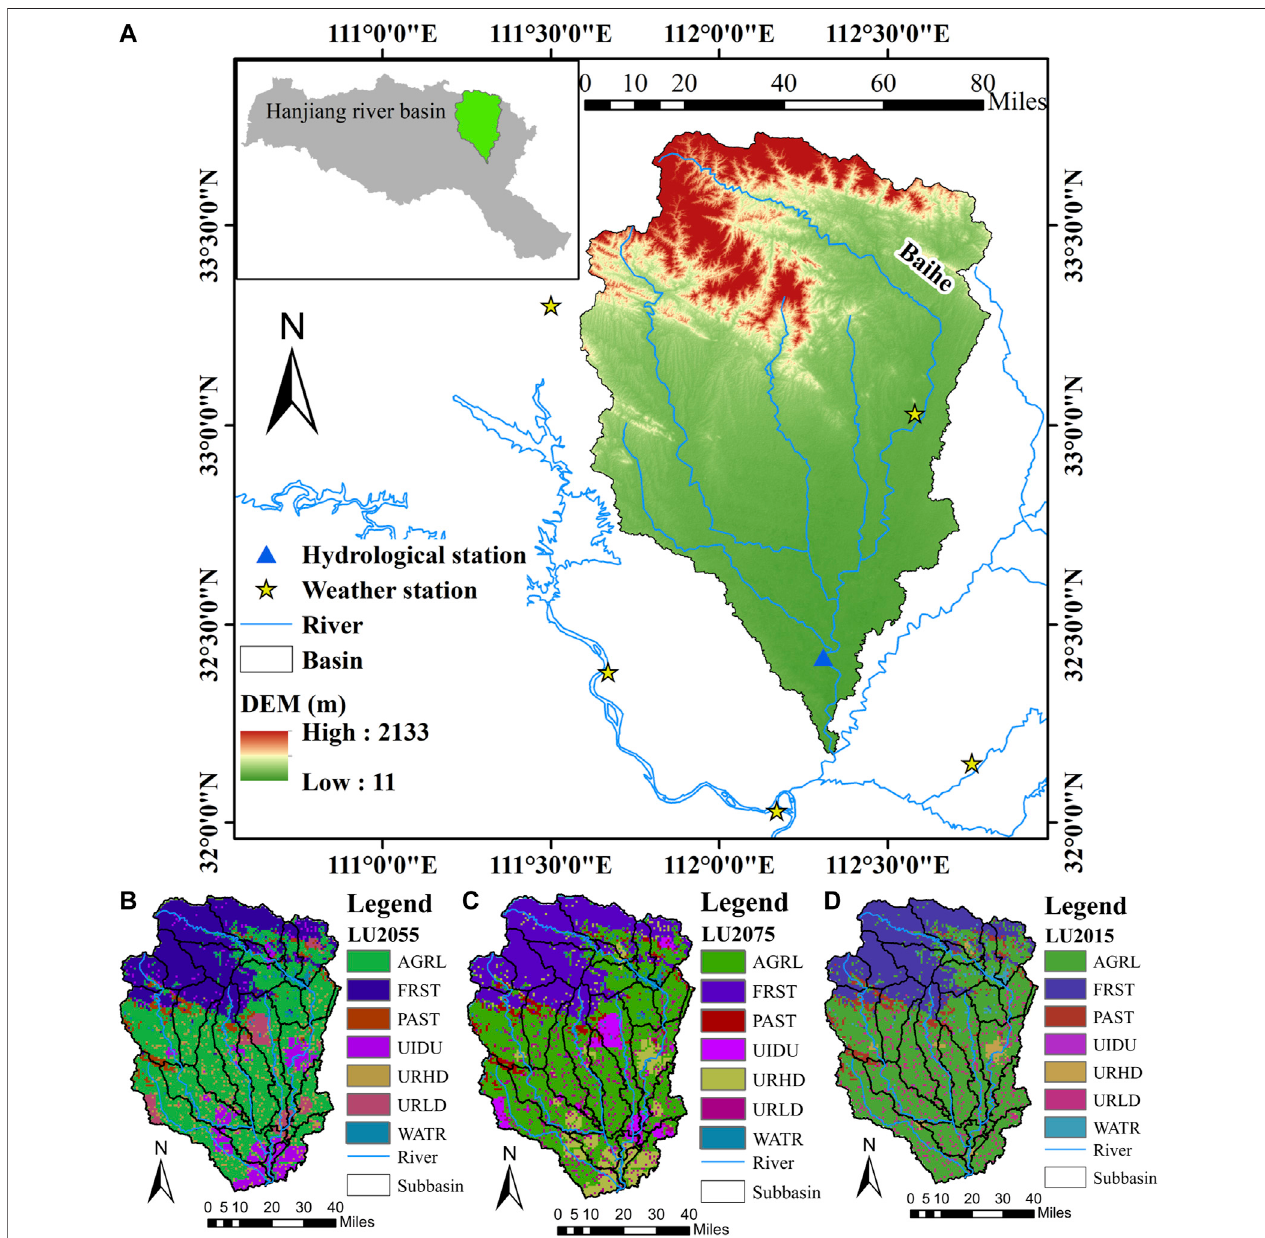
FIGURE 1 | Study area along with hydrologic station and climate stations and the land-use map for LU 2015, LU 2055, and LU 2075.